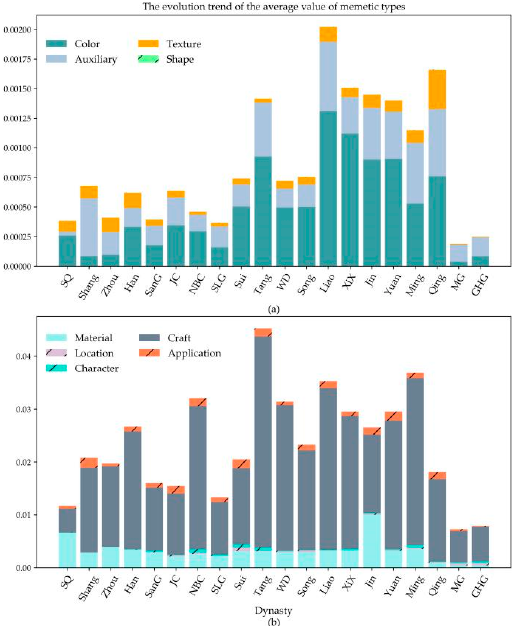
Figure 6. Distribution trend of meme types. ( a ) Shows the distribution trend of the four meme types: color, texture, auxiliary, and shape, and ( b ) Shows the distribution trend of the five meme types: material, craft, location, application, and character.